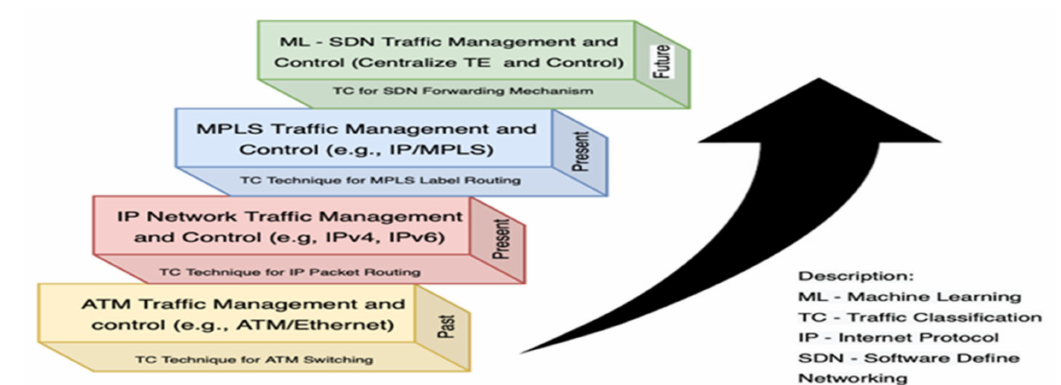
Figure 1. Depicts the roadmap of traffic classification concepts from past to